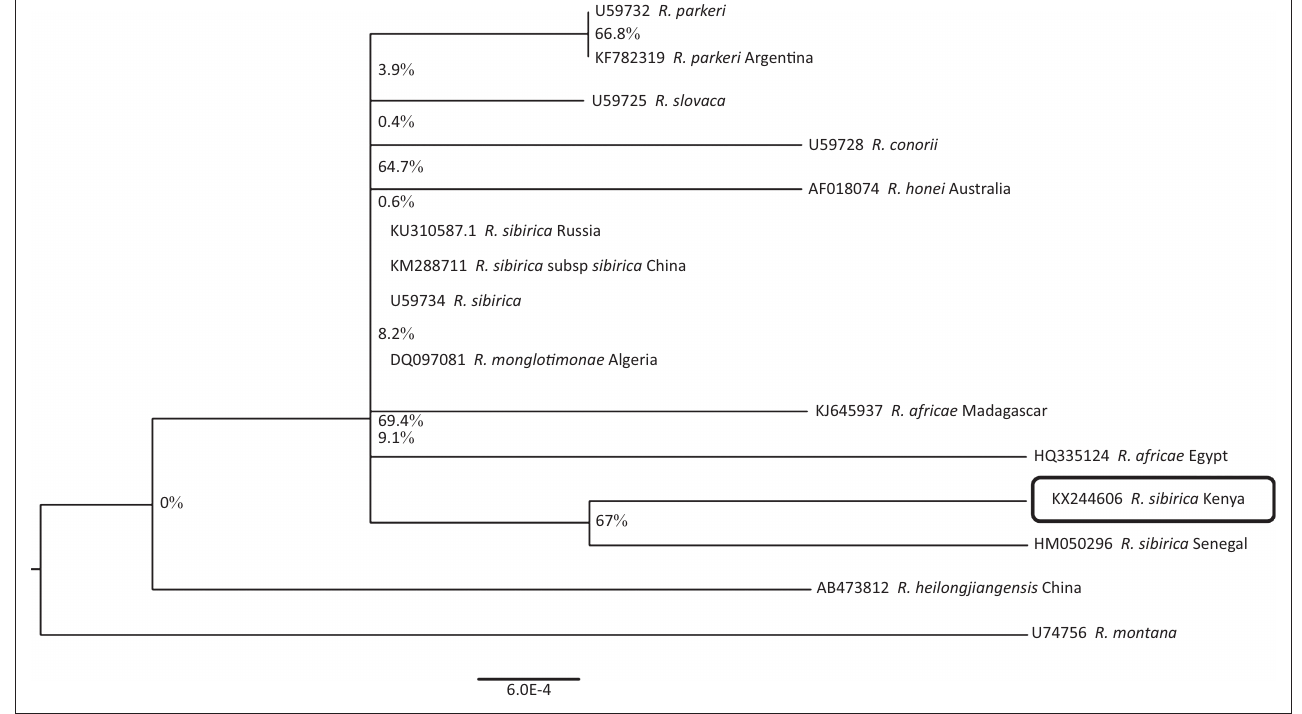
FIGURE 3: A phylogenetic relationship between Rickettsia sibirica isolated from Topi in Kenya and other Rickettsia sequences in the